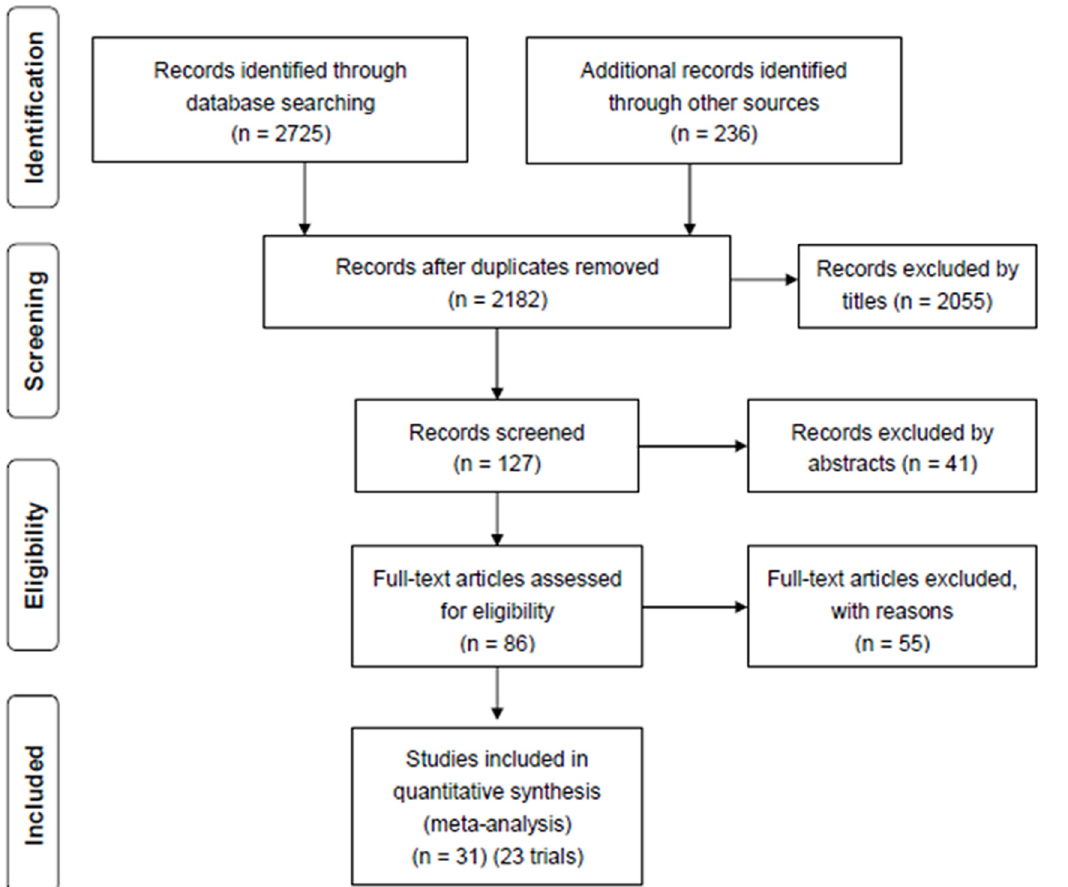
Fig 1. Flow diagram of studies considered for